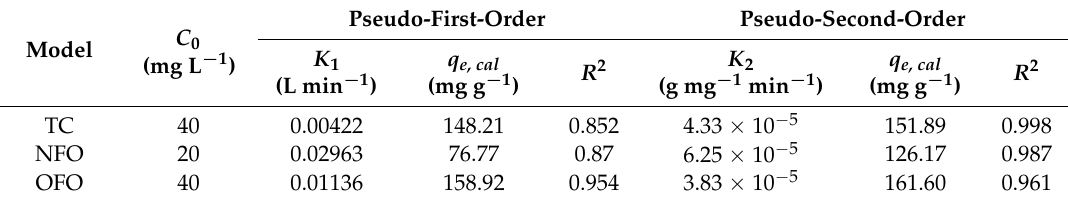
Figure S1: The chemical structure of TC, NFO and OFO. Figure S2: The Low-(a) and High-magnification (b) SEM images of the synthesized ZIF-8 without CTAB. Figure S3: The isothermal adsorption fitting curves of Langmuir (a,b) and Freundlich (c,d) for TC, OFO and NFO by